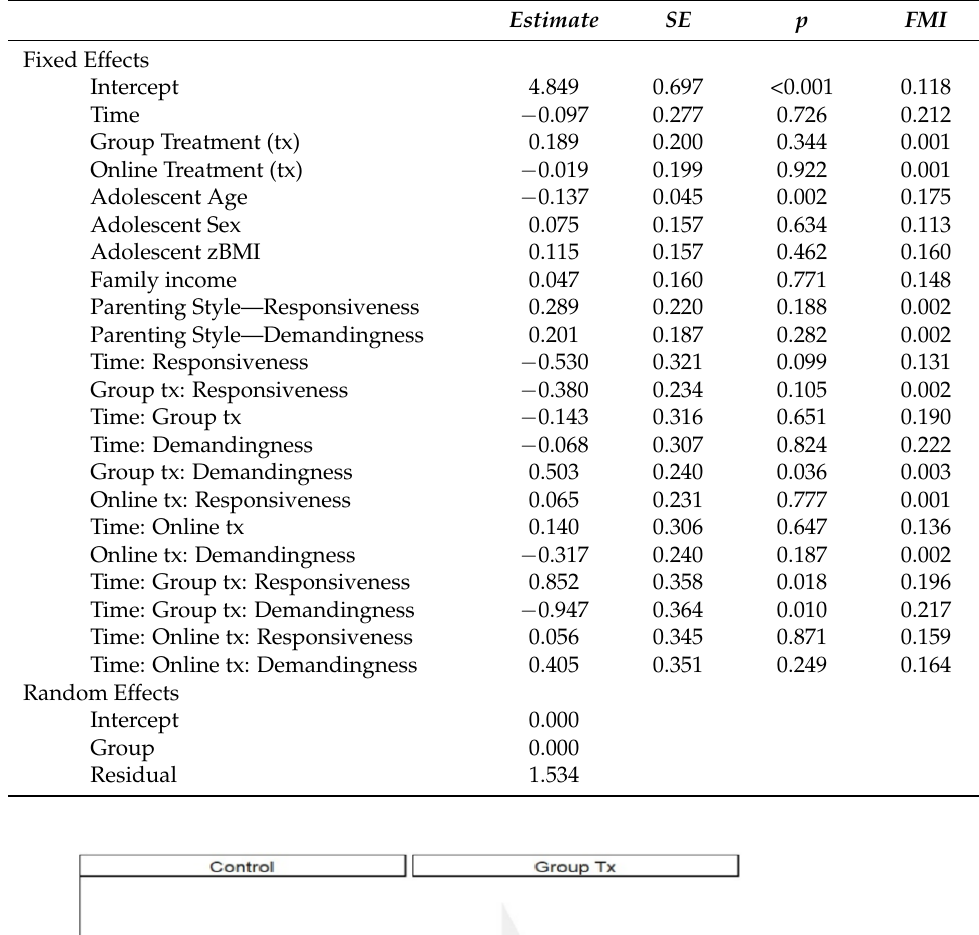
Table 3. Multilevel model with parenting style predicting family mealtime from baseline to 16 weeks.